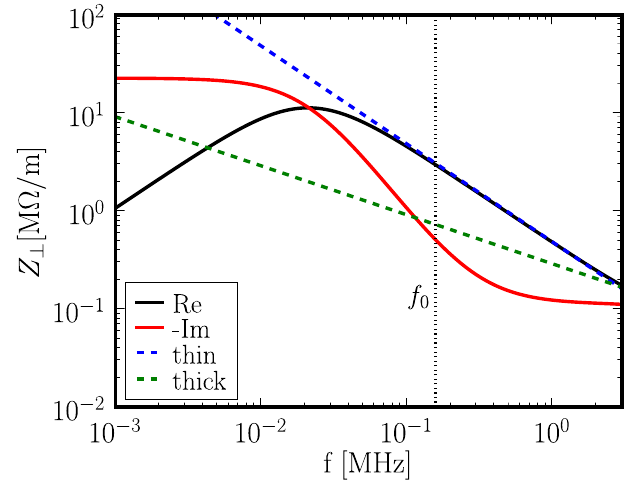
FIG. 2. (Color) The transverse resistive-wall impedance Eq. (27) as a function of the frequency for a fixed wall thickness d (cid:2) 0 : 3 mm and for SIS 100 parameters. Also shown are the thin and thick wall approximation results. The revolution frequency f SIS 100 injection is indicated.